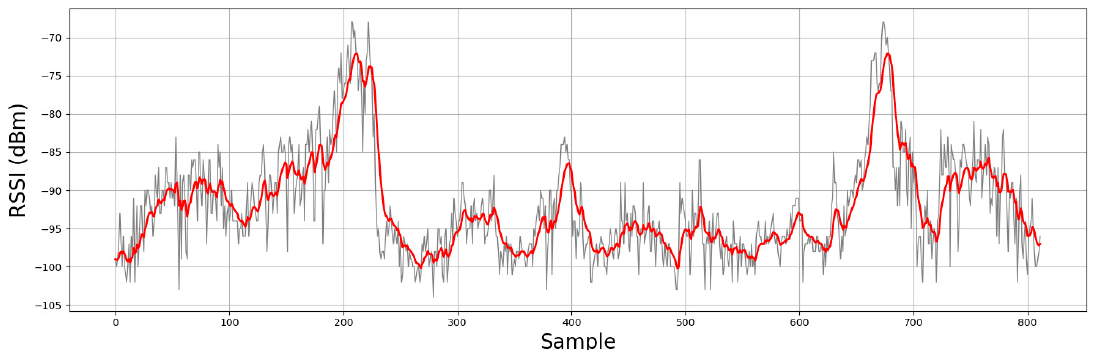
Figure 4. RSSI signal of beacon placed in the door. In gray, the raw RSSI signal. In red, the filtered RSSI signal.